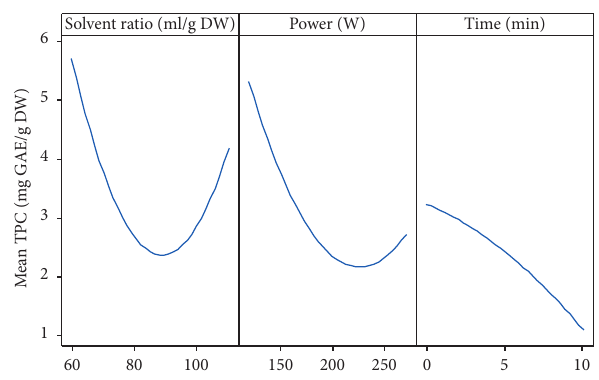
Figure 2: Effects of solvent/raw material ratio, power, and time on TPC.